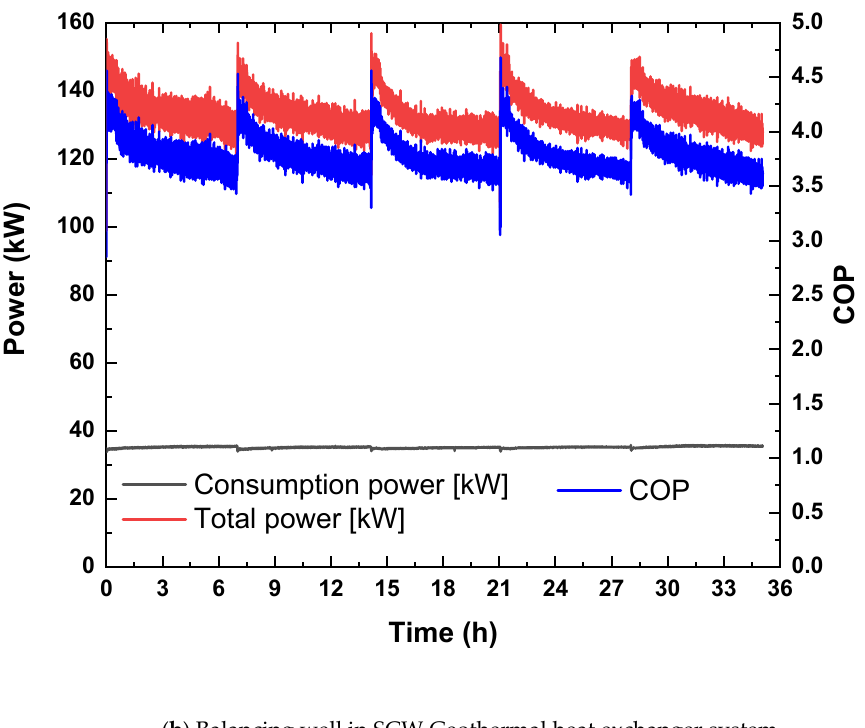
Figure 4. COP characteristics of the SCW and BW cross-mixing ground heat exchanger system during cooling operation.